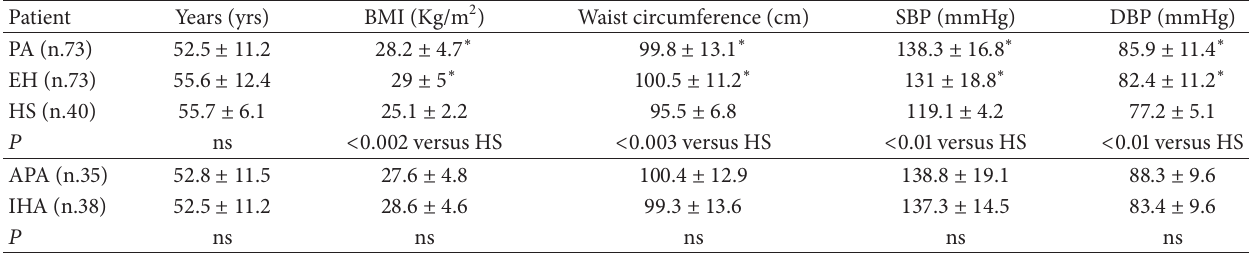
Table 1: Demographic and anthropometric parameters in all subjects enrolled.